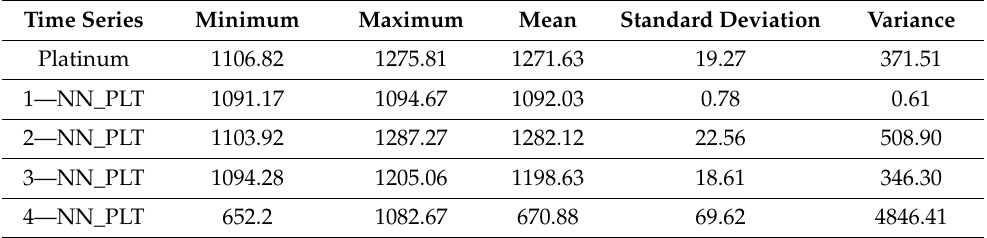
Table 3. Statistical characteristics of historical time series and predicted platinum prices. Time Series Minimum